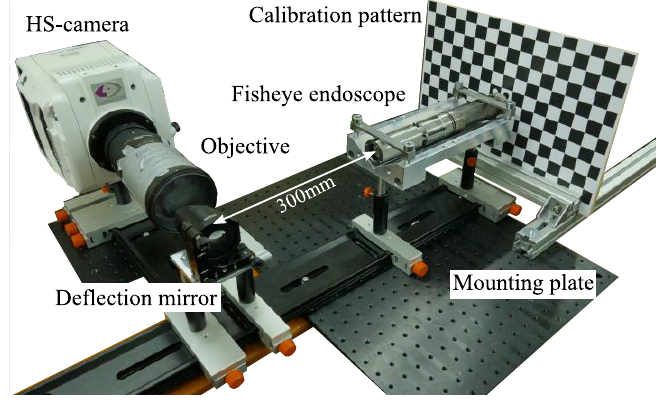
Figure 10. Calibration Setup.